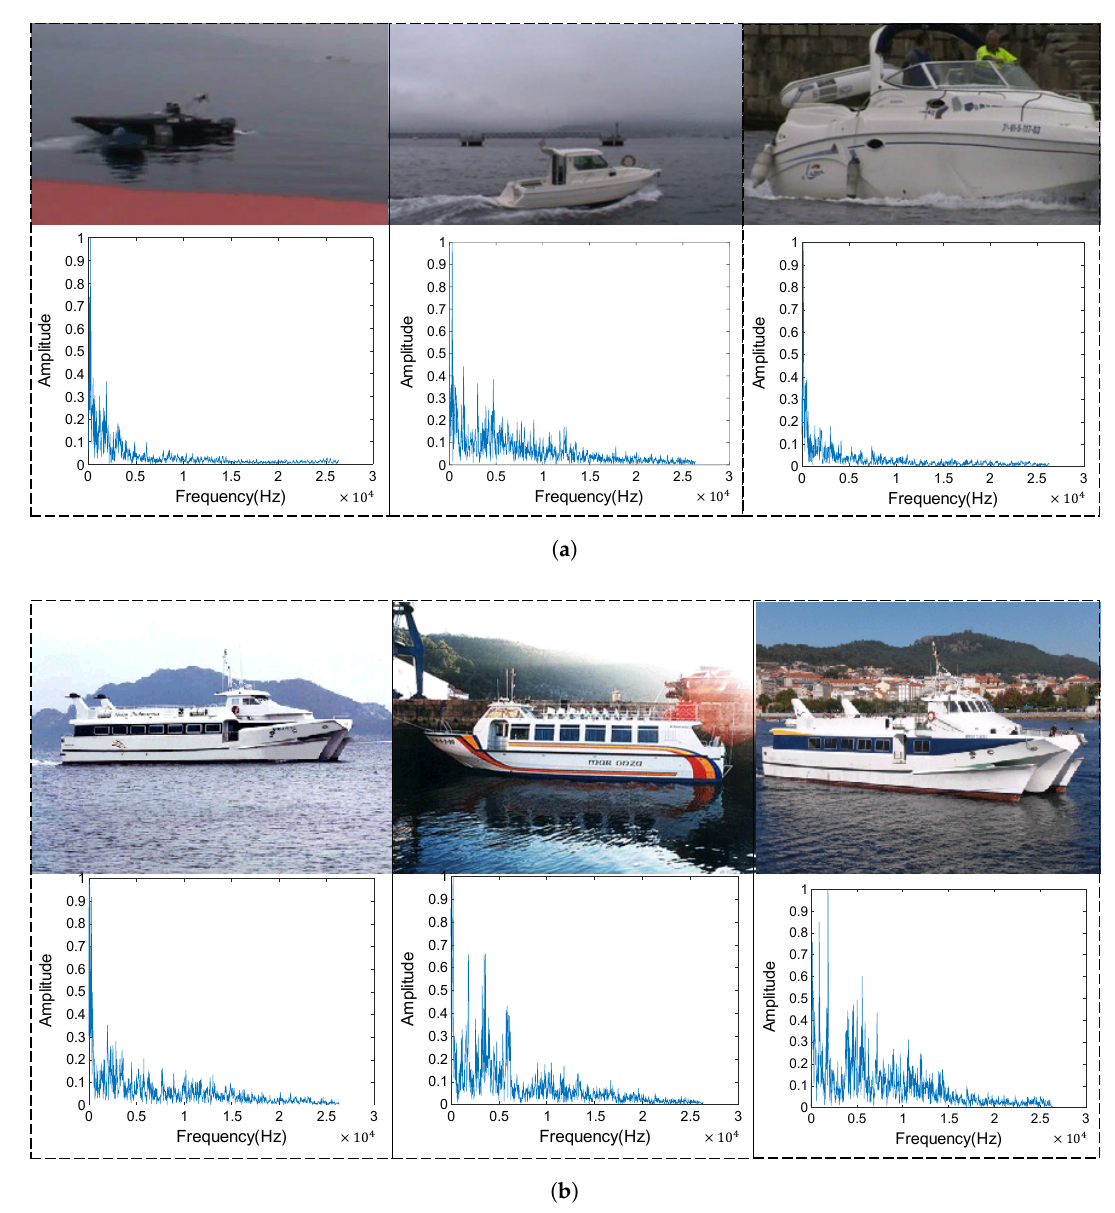
Figure 8. Some originally recorded samples. ( a ) Pictures and spectrum of the recorded samples in class 1. ( b ) Pictures and spectrum of the recorded samples in class